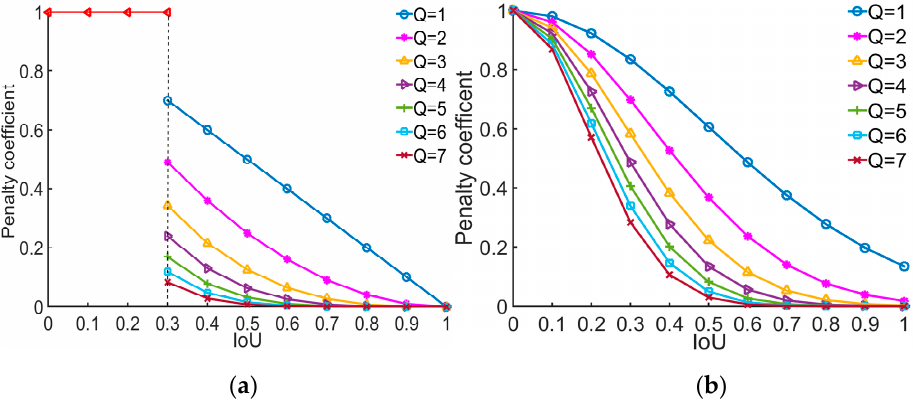
Figure 10. Relationships between penalty coefficient, intersection over union (IoU), and Q. ( a ) The relationship between penalty coefficient of linear weighting, IoU, and Q; ( b ) relationship between penalty coefficient of Gaussian weighting, IoU, and Q.